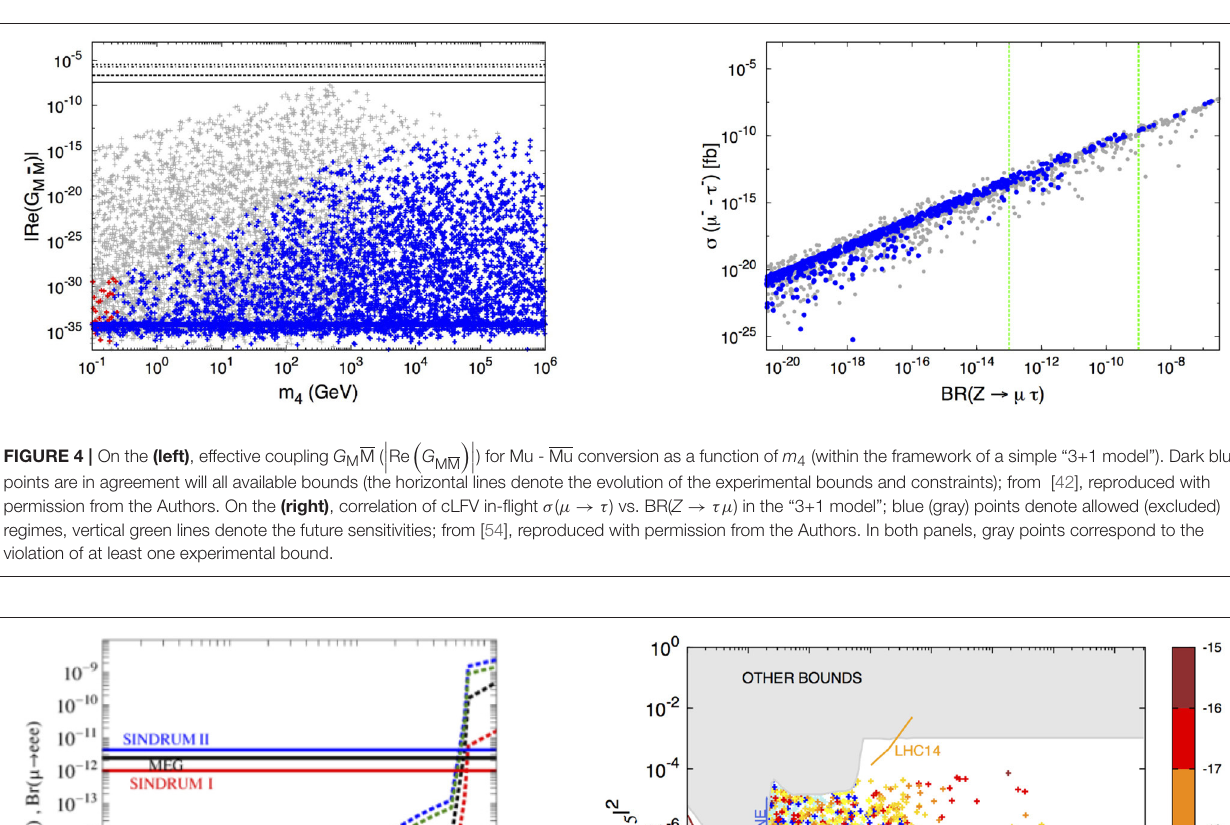
FIGURE 5 | On the (left) , maximal allowed cLFV rates compatible with current searches in a low-scale seesaw; horizontal full (dashed) lines denote present (future) experimental sensitivity. From [ 41], reproduced with permission from the Authors. On the (right) , logarithm of BR( µ − e − parameter space of a (3,3) ISS realisation; the shaded surfaces correspond to the exclusion from BBN (rose) or from the violation of at least one experimental bound (gray), while solid lines delimit the expected sensitivity of several facilities (from [42], reproduced with permission from the Authors).